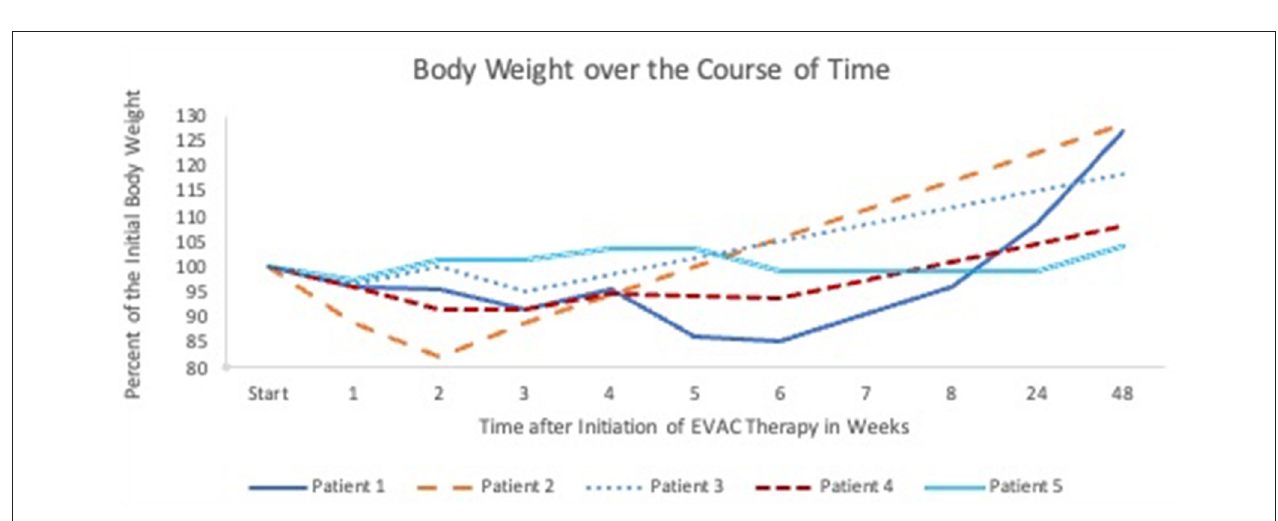
FIGURE 3 | This graph shows the course of body weight over the 1 year after